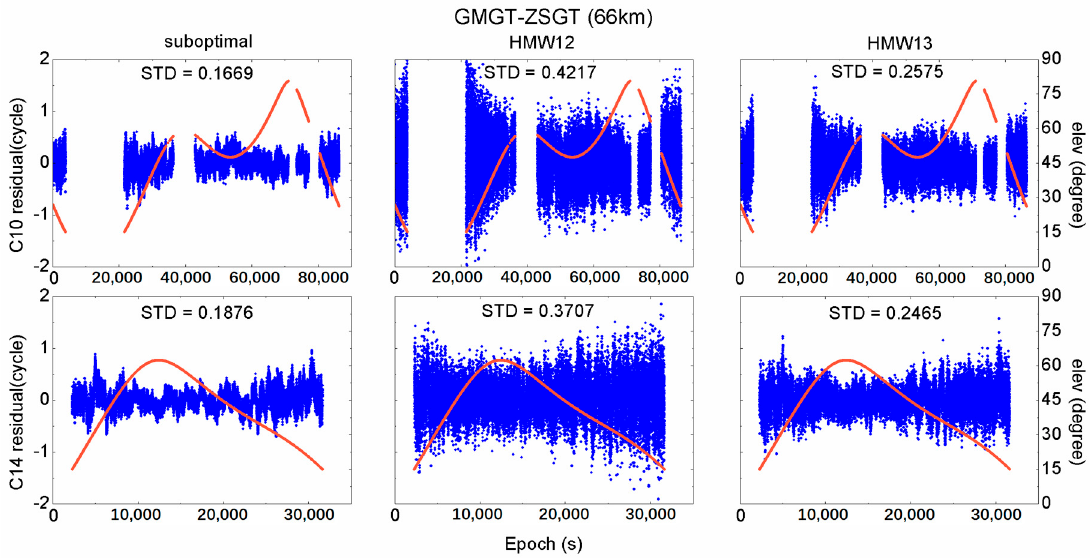
Figure 6. Comparison of ambiguity residuals and the corresponding standard deviations of suboptimal , HMW 12, and HMW 13 combinations for the medium baseline (66 km).